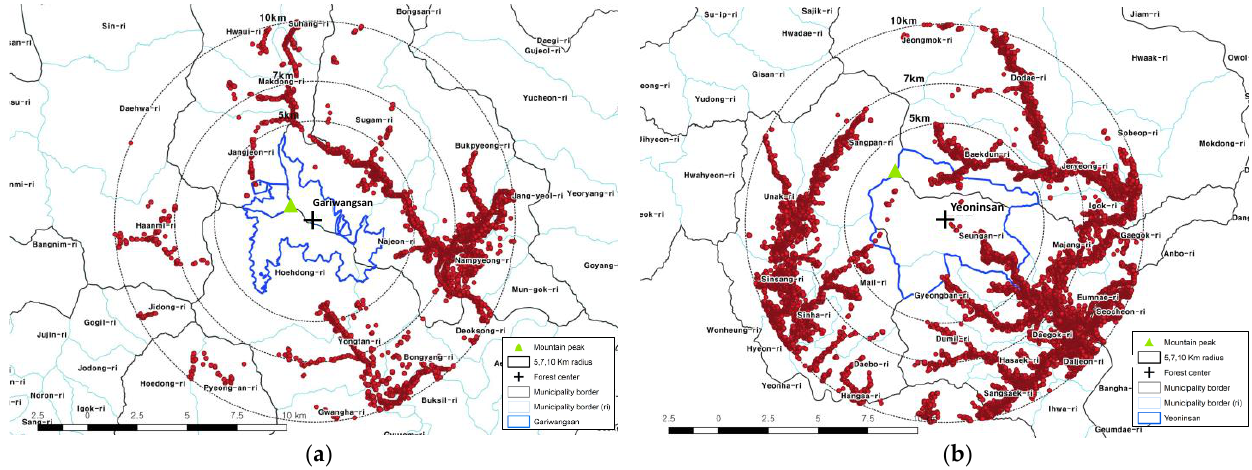
Figure 11. Spatial distribution of the floating populations in ( a ) Gariwangsan and ( b ) Yeoninsan. Figure 12 shows the floating population sizes for each forest; as the graph shows, the total floating population of Yeoninsan is eight to nine times larger than that of Gariwangsan. This difference is reasonable, because Yeoninsan is closer to the capital of South Korea, hosting the largest population in the nation. Both forests had the largest floating population in December, followed by June, September, and March (Table 7).